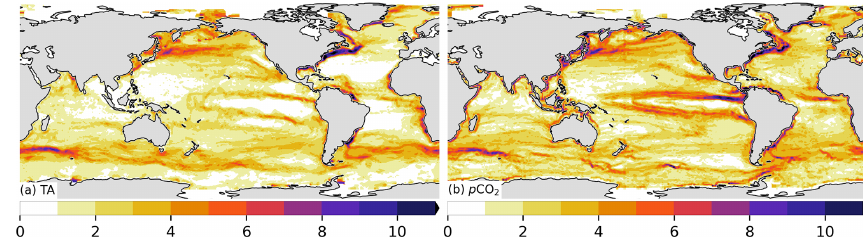
Figure A5. Map of the position of cluster boundaries across all ensemble members and months for (a) total alkalinity and (b) p CO 2 . The white regions indicate locations that belong almost exclusively to the same cluster. Dark regions show where cluster boundaries are persistent.